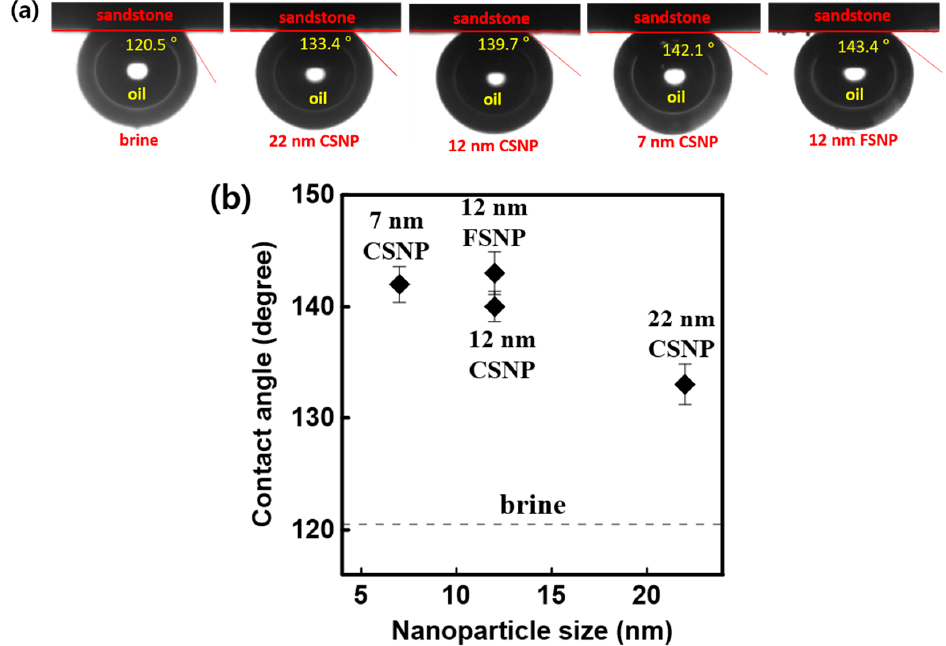
Figure 7. (a) Contact angles of differently sized NPs and ( b ) contact angles as a function of NP size.